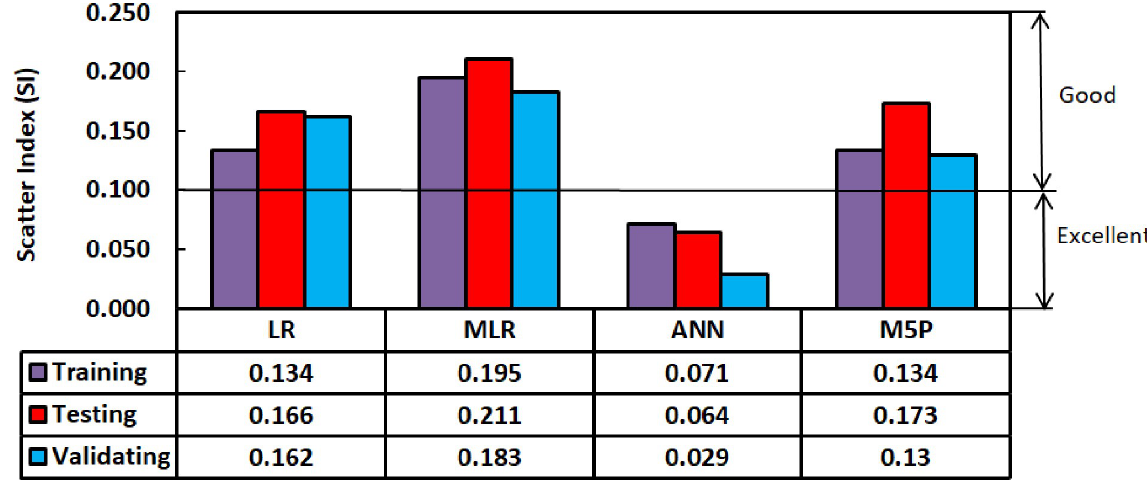
Fig 15. Scatter index (SI) performance for the models used in this study.